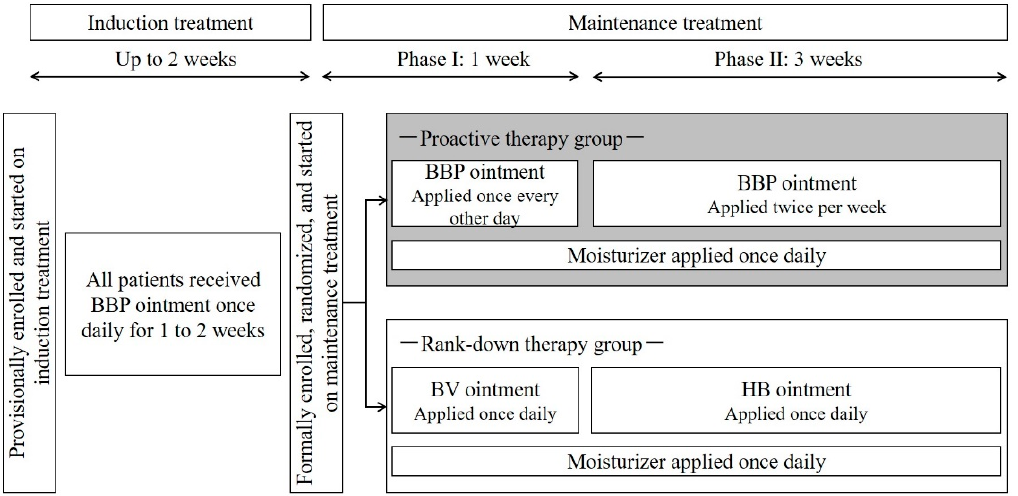
Figure 1. Study design. Abbreviations: BBP, betamethasone butyrate propionate; BV, betamethasone valerate; HB, hydrocortisone butyrate.